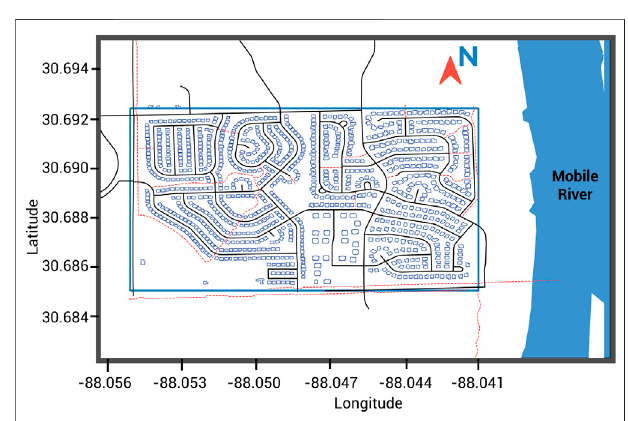
FIGURE 4 | Portion of the community considered in the resilience